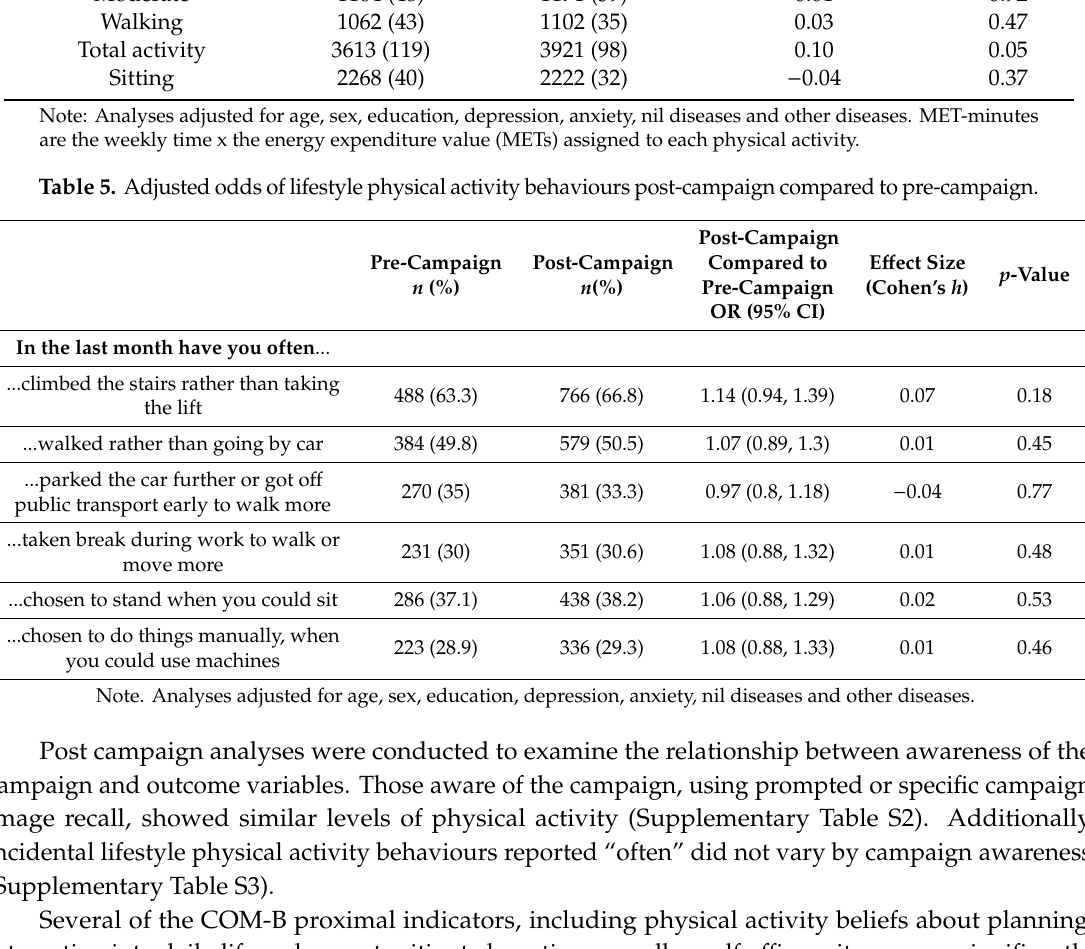
Table 4. Adjusted physical activity for all respondent’s pre-campaign and post-campaign. Pre-Campaign Post-Campaign E ff ect Size (Cohen’s d ) p -Value Weekly MET minutes Mean (SE) Vigorous 1497 (75) 1769 (61) 0.13 < 0.01 Moderate 1164 (48) 1171 (39) 0.01 0.92 Walking 1062 (43) 1102 (35) 0.03